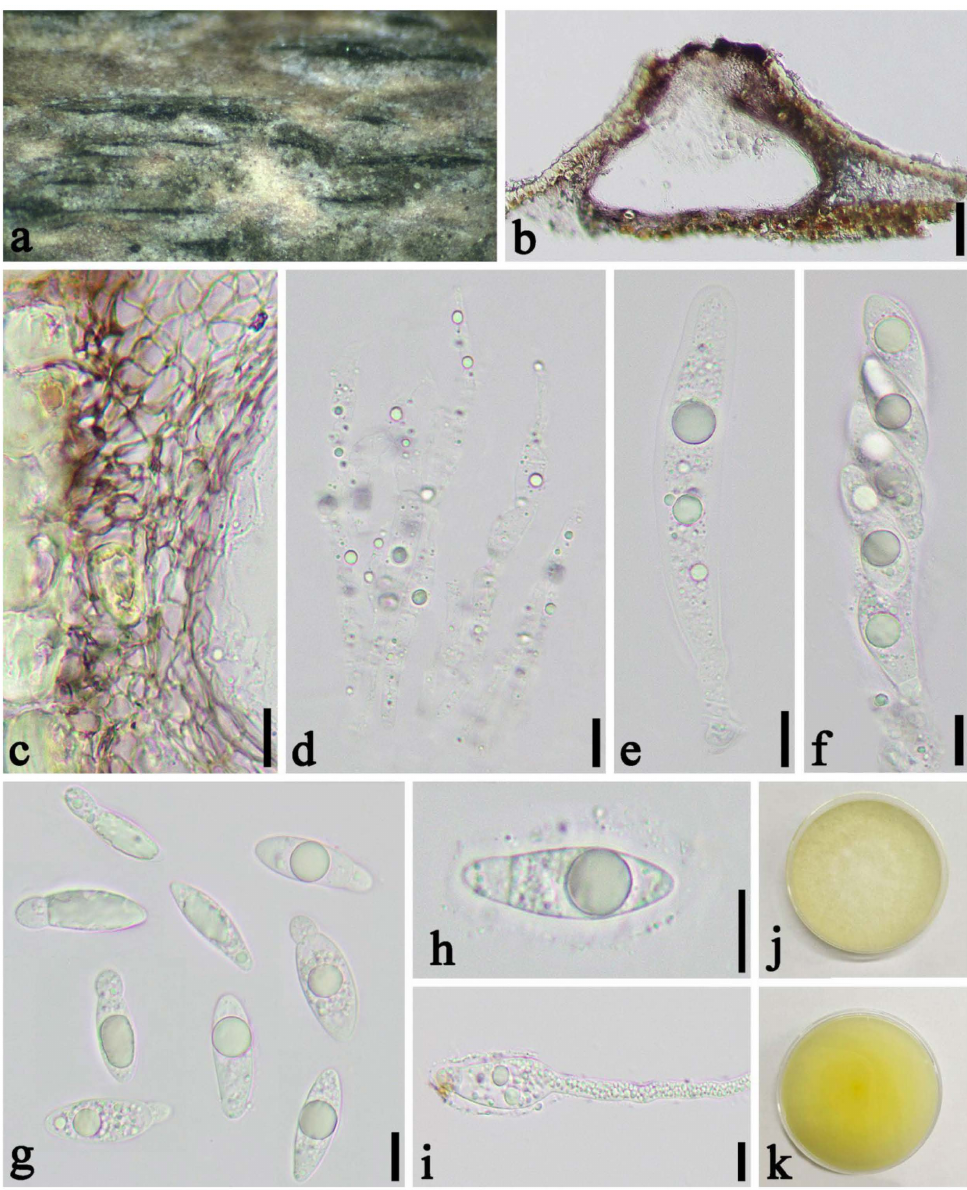
Figure 5. Apiospora hydei (SICAU 22-0032). ( a ) Ascostromata developing on bamboo branches. ( b ) Vertical sections of ascostromata. ( c ) Peridium. ( d ) Paraphyses. ( e , f ) Asci. ( g , h ) Ascospores. ( i ) Germinating ascospore. ( j , k ) Cultures on PDA. Scale bars: ( b ) = 50 µ m, ( c – i ) = 10 µ m. Material examined: China, Sichuan Province, Luzhou City, Xuyong District (27 ◦ 53 (cid:48) 28 (cid:48)(cid:48) N, 105 ◦ 16 (cid:48) 36 (cid:48)(cid:48) E, Alt. 1350 m), on dead culm of Phyllostachys heteroclada , 26 July 2021, Qian Zeng, ZQ202107133 (SICAU 22-0070), living culture SICAUCC 22-0070. Culture characters: Ascospores germinate on PDA within 24 h. Colonies grow fast on PDA, reaching 6 cm after 1 week at 25 ◦ C, under 12 h light/12 h dark, and are cottony, white, circular, with irregular